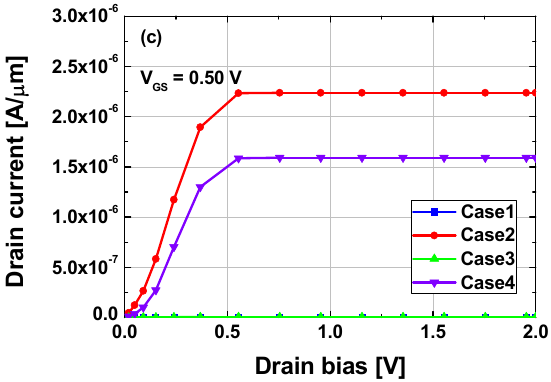
Figure 2. Simulated transfer characteristics (( a ) V DS = 0.5 V, ( b ) V DS = 0.95 V) and output characteristics (( c ) V GS = 0.5 V) of Cases1–4.